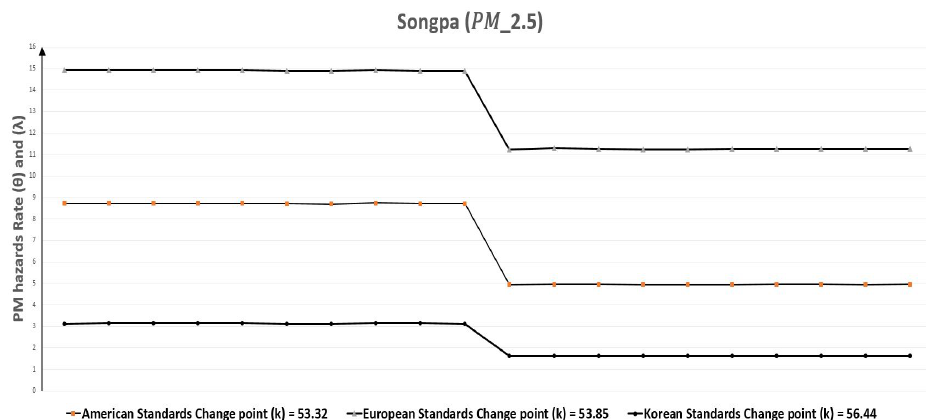
Figure 22. Songpa (Seoul, South Korea) monthly polluted days before and after the change point due to PM 2.5 .